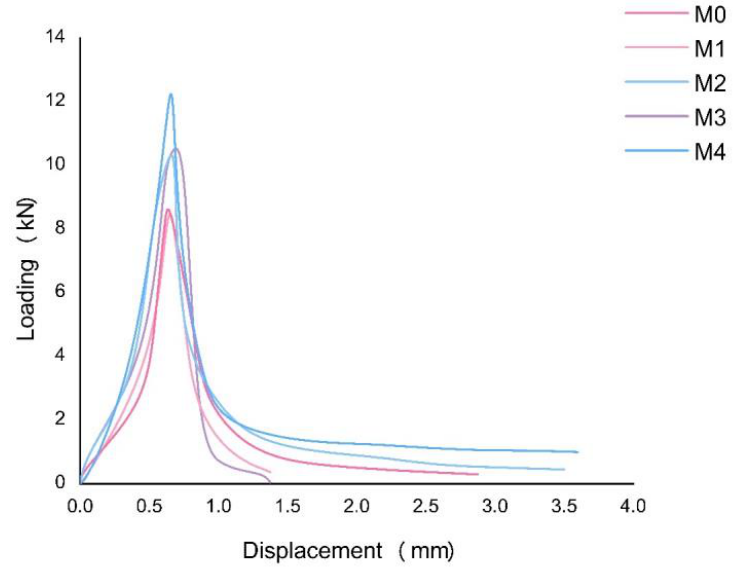
Figure 6. The load-displacement curve of the bending test.